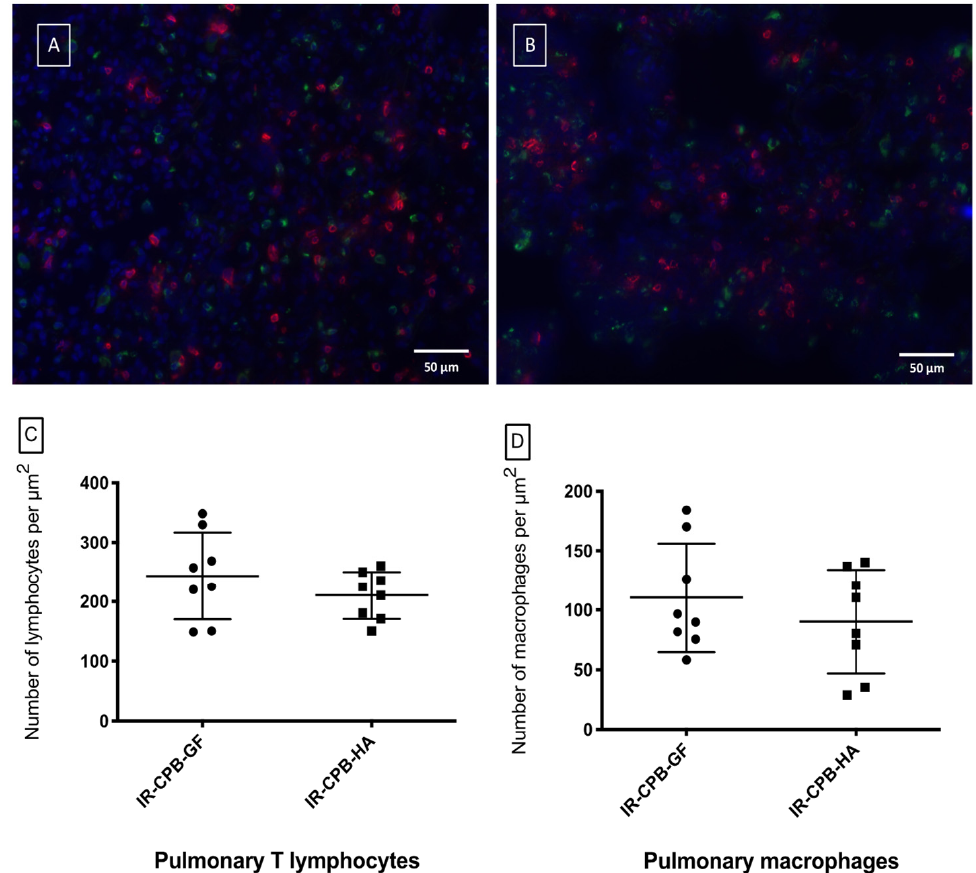
Figure 4. Immunohistology (magnification x40, scale bar = 50 µm). Fluorescent immuno-histological marking of the pulmonary parenchyma of the IR-CPB-GF group ( A ) and the IR-CPB-HA group ( B ). For all the groups, macrophages (CD68) are marked in green and lymphocytes (CD3) are marked in red. ( C ) Pulmonary T lymphocytes (CD3) of the left lung tissue. ( D ) Pulmonary macrophages (CD68) of the left lung tissue. For statistical analyses, ANOVA was used, followed by Tukey’s multiple comparison (post hoc) testing. A result with p < 0.05 was considered to be statistically significant. Data are presented as mean ± SD. Abbreviations: CPB, cardiopulmonary bypass; IR, left lung ischemia–reperfusion; HA, human albumin.